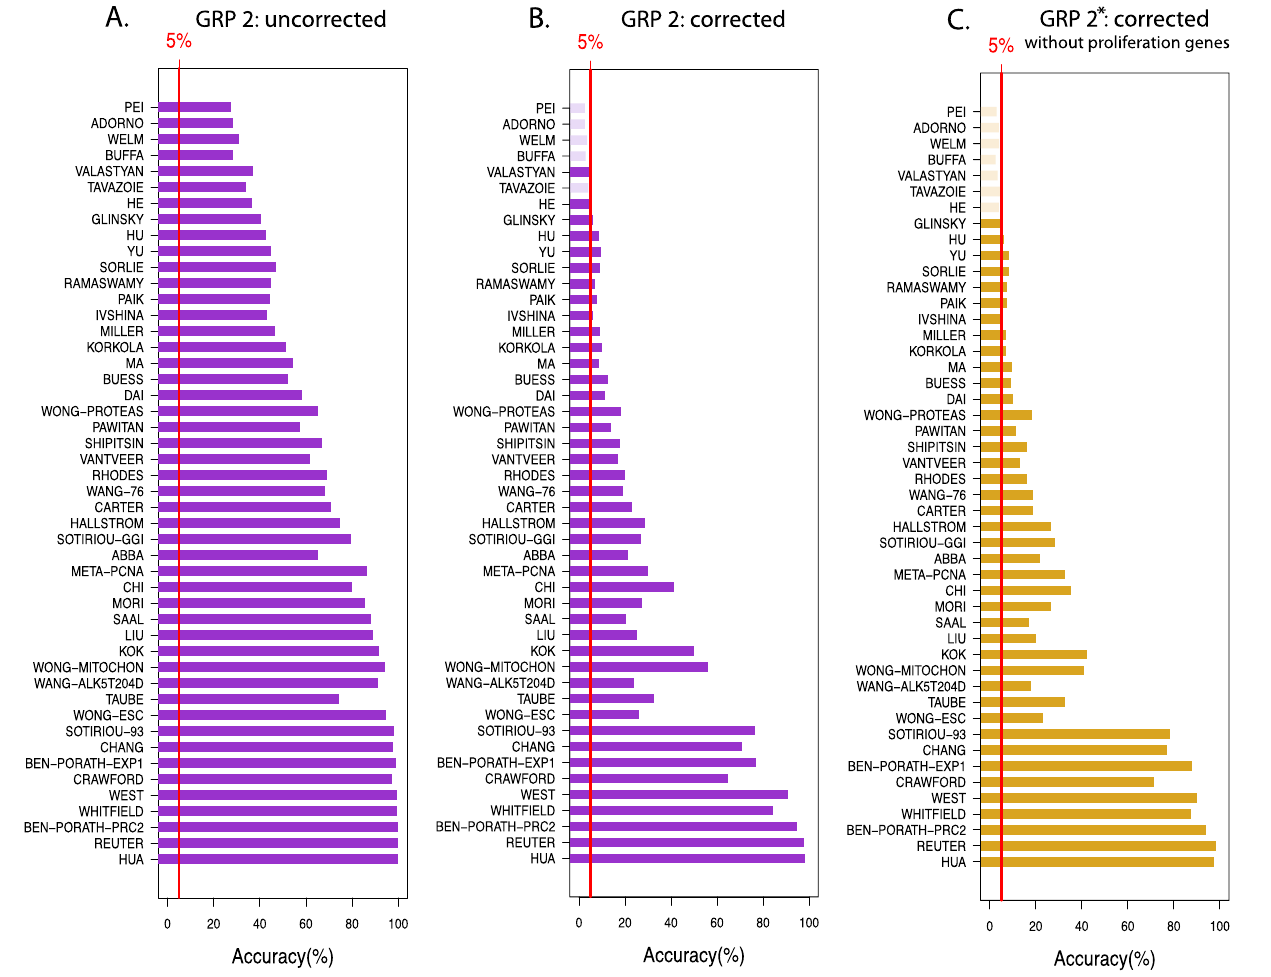
Figure 5. Results for gene removal procedure 2 for the NKI data. ( A ), ( B ) Show results for the minimal accuracy values across all hierarchy levels, whereas A is for uncorrected p-values and B for Bonferroni corrected p-values. ( C ) Results for GRP 2* for removing all GO-terms on all hierarchy levels (Bonferroni